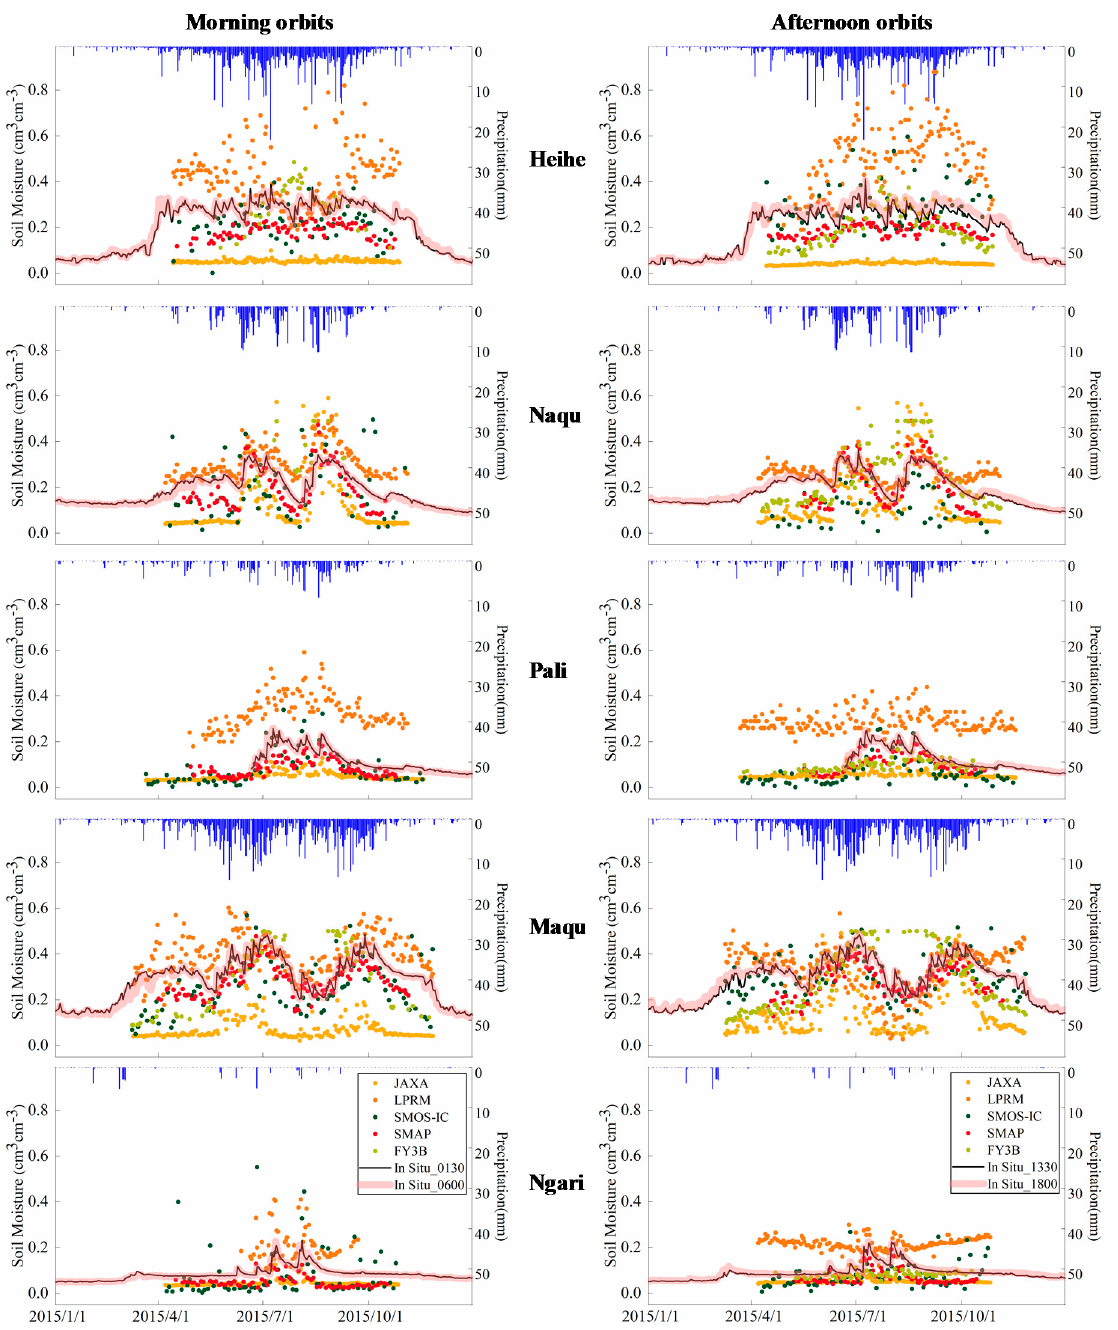
Figure 3. Time series that compare soil moisture active passive (SMAP), soil moisture and ocean salinity INRA-CESBIO (SMOS-IC), Fengyun-3B microwave radiation image (FY3B), Japan Aerospace Exploration Agency (JAXA) and land parameter retrieval model (LPRM) SM products with in situ measurements for 2015.